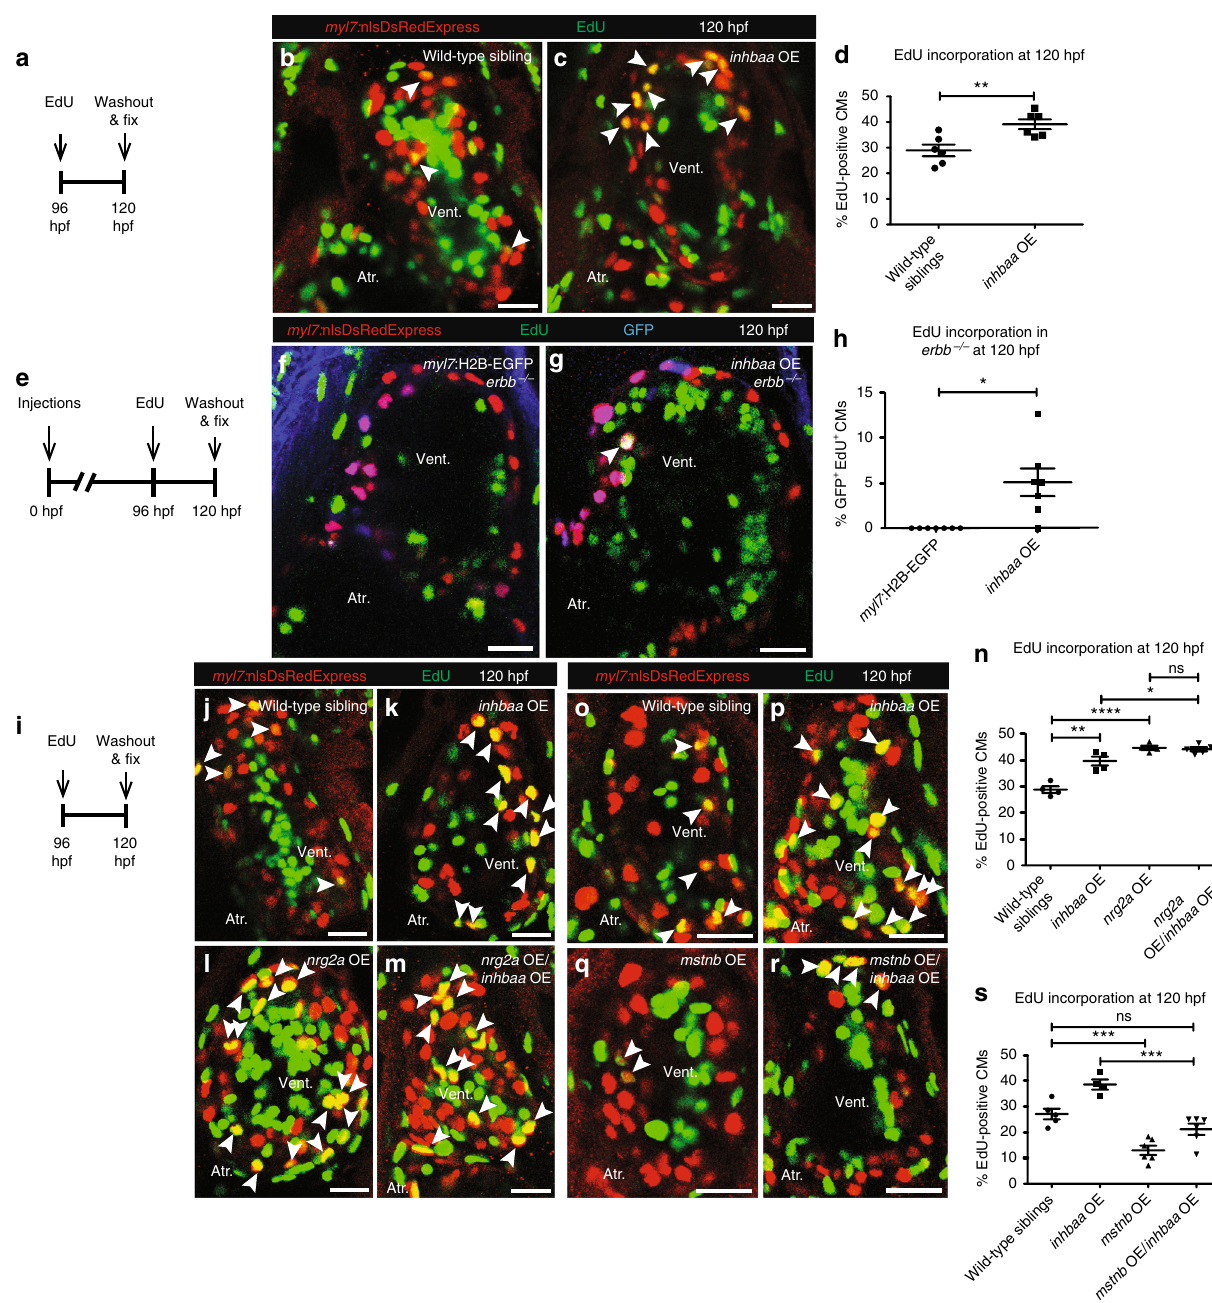
Fig. 4 inhbaa GOF promotes CM proliferation independently of ErbB2 signaling and competes with m stnb GOF. a Experimental setup of EdU treatment, followed by fi xation. b , c Tg(myl7:nlsDsRedExpress) hearts of wild-type sibling and inhbaa OE larvae at 120 hpf; α -DsRed (red), EdU (green). White arrowheads point to proliferating CMs (EdU + /DsRed + ). d Quanti fi cation of CM proliferation in wild-type sibling ( n = 6) and inhbaa OE ( n = 6) ventricles at 120 hpf. e Experimental setup of injections, EdU exposure, followed by fi xation. f , g Tg(myl7:nlsDsRedExpress) hearts of myl7:H2B-EGFP and myl7:inhbaa-2A- H2B-EGFP(inhbaa OE) injected erbb − / − larvae at 120 hpf; α -DsRed (red), α -GFP (blue), EdU (green). White arrowheads point to proliferating CMs (EdU + /DsRed + /GFP + ). h Quanti fi cation of CM proliferation in myl7:H2B-EGFP ( n = 7) and inhbaa OE ( n = 7) injected ventricles at 120 hpf. i Experimental setup of EdU treatment, followed by fi xation. j – m Tg(myl7:nlsDsRedExpress) hearts of wild-type sibling, inhbaa OE, nrg2a OE, and nrg2a OE/ inhbaa OE larvae at 120 hpf; α -DsRed (red), EdU (green). White arrowheads point to proliferating CMs (EdU + /DsRed + ). n Quanti fi cation of CM proliferation in wild-type sibling ( n = 4), inhbaa OE ( n = 4), nrg2a OE ( n = 4), and nrg2a OE/ inhbaa OE ( n = 5) ventricles at 120 hpf. o – r Tg(myl7:nlsDsRedExpress) hearts of wild-type sibling, inhbaa OE, mstnb OE, and mstnb OE/ inhbaa OE larvae at 120 hpf; α -DsRed (red), EdU (green). s Quanti fi cation of CM proliferation in wild-type sibling ( n = 5), inhbaa OE ( n = 4), mstnb OE ( n = 6), and mstnb OE/ inhbaa OE ( n = 6) ventricles at 120 hpf. All cell counts were performed on non-overlapping confocal planes (thickness, 1 µ m) (data are mean ± s.e.m., ns: no signi fi cant changes observed, * P ≤ 0.05, ** P ≤ 0.01, *** P ≤ 0.001 and **** P ≤ 0.0001 — Student ’ s t test, two-tailed). Scale bars, 20 µ m. vent., ventricle; atr.,